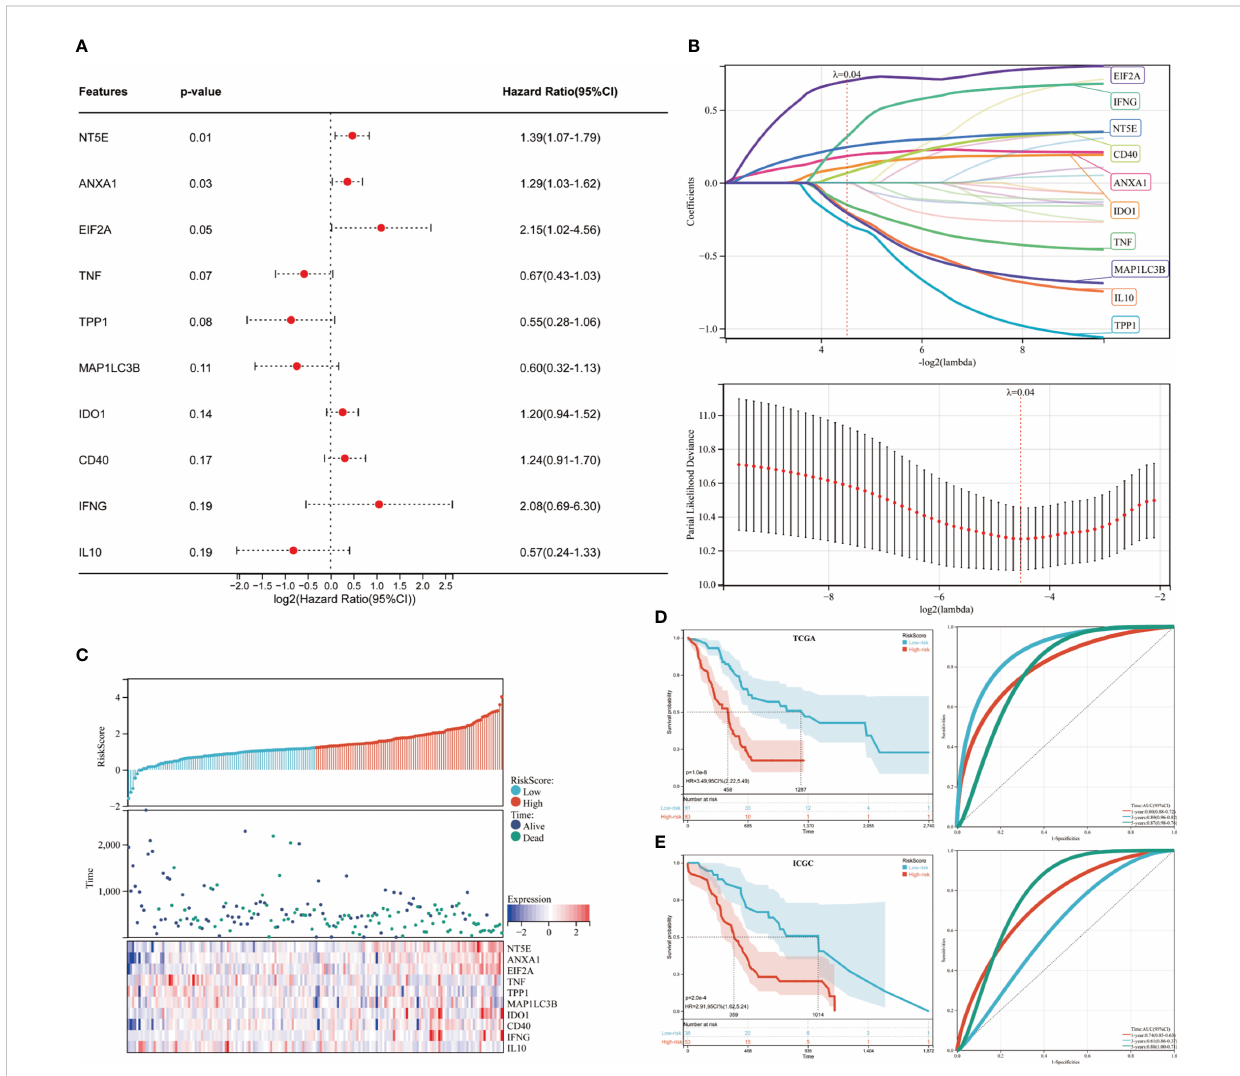
FIGURE 5 Developing and validating the ICD risk signature. (A) Multivariate Cox analysis assesses the prognostic value of ICD genes in terms of OS; (B) Lasso Cox analysis identi fi ed ten genes most associated with OS in the TCGA dataset; (C) Distribution of risk scores, survival status of each patient, and heatmaps of prognostic 10-gene signature in the TCGA database; (D, E) Kaplan-Meier analyses demonstrate the prognostic signi fi cance of the risk model in the TCGA and ICGC